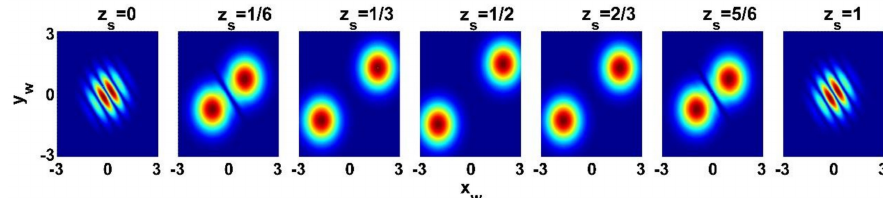
Figure 2. Evolution of intensity distributions of sin-Gaussian beams with the scaled propagation distance z s for β x = 4, β y = 3. The other parameters are R 0x = R 0y = ∞ and z p = z R